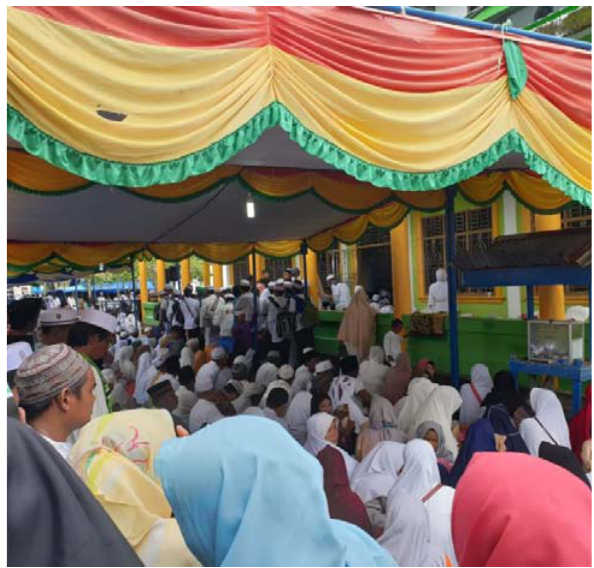
Figure 2. Pilgrims participating in the religious gathering organized by local authorities in Tembilahan (Source: Authors’ collection).